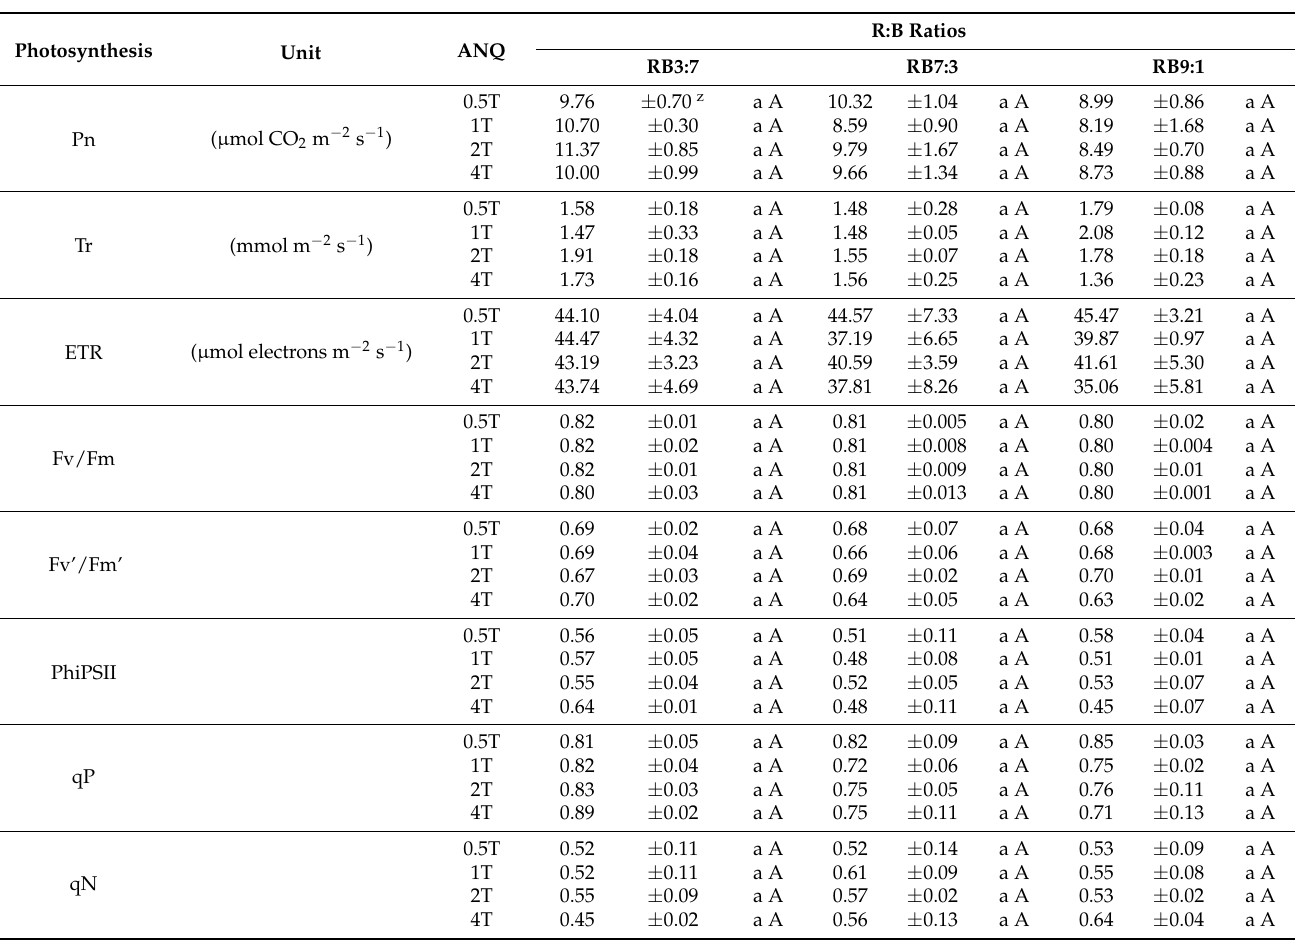
Table 4. Photosynthesis parameters of basil plants grown under different ANQ treatments and R:B